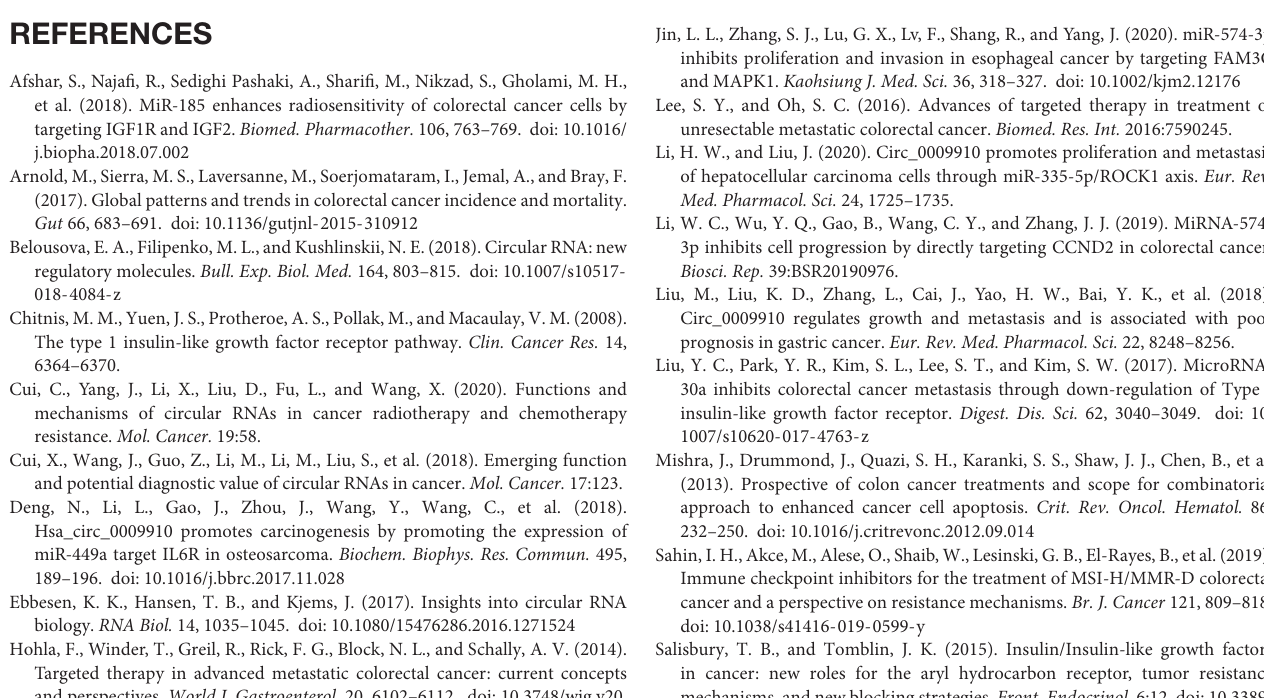
Supplementary Figure 1 | The expression of linear MFN2 under the treatment of si-circ-MFN2. SW620 and SW480 cells were transfected with si-NC or si-circ-MFN2, and non-transfected cells were used as control. The mRNA and protein expression levels of MFN2 were determined using qRT-PCR (A) and WB analysis (B)